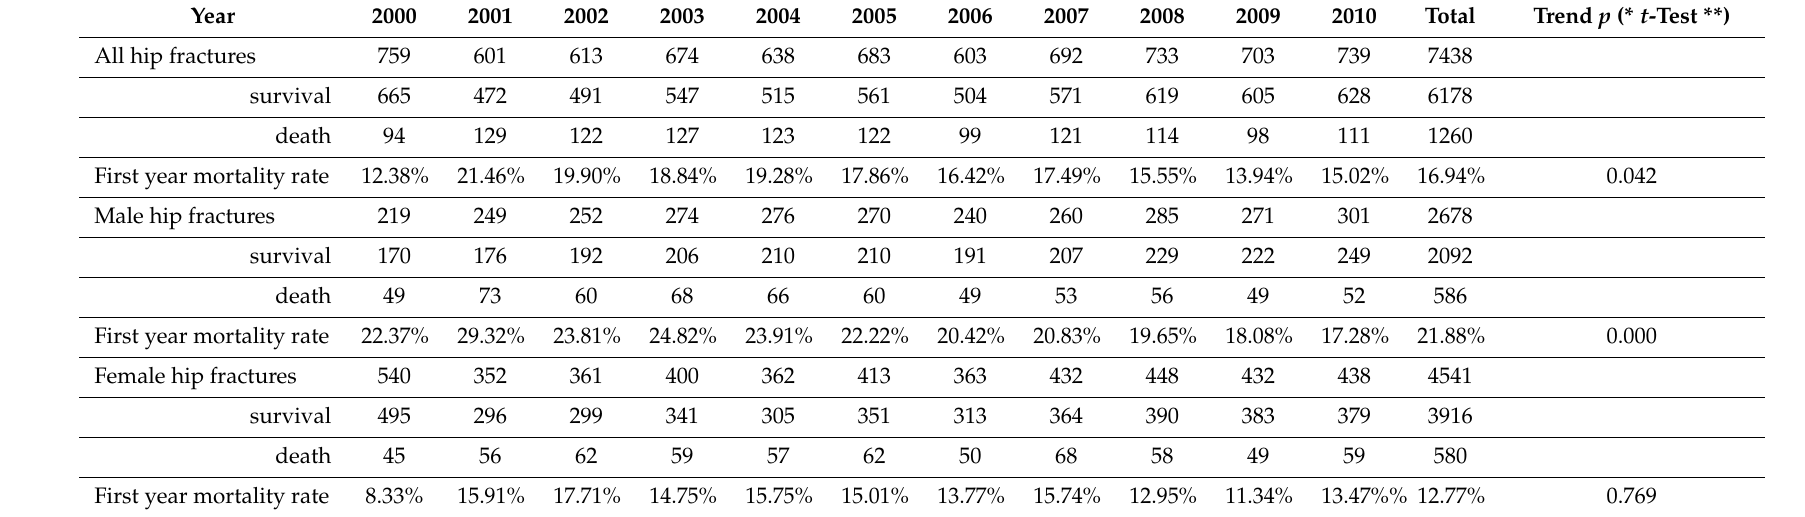
Table 3. First year mortablity following hip fracture from 2000 to